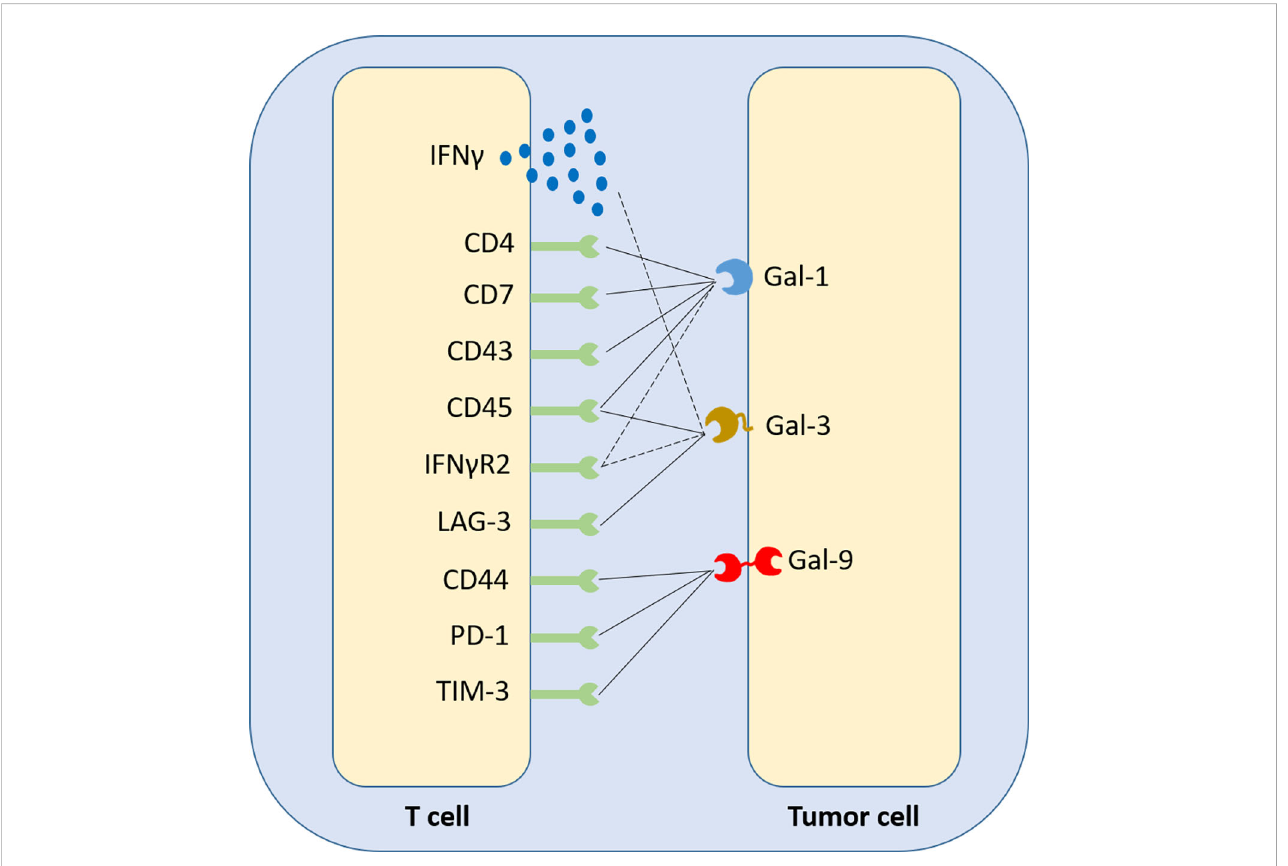
FIGURE 4 Synthetic representation of the crosstalk between galectins and T-cell surface receptors. Gal-1, Gal-3 and Gal-9 have been identi fi ed to be ligands of various membrane receptors, acting as checkpoint inhibitors. Depending on the member of the galectin family and the biology of the respective T-cell membrane receptor, or secreted cytokine, the immunosuppressive effect of galectins on T cells may have three distinct forms; two direct, causing T-cell apoptosis or a switch towards an exhausted phenotype (solid lines) and one indirect, suppressing T-cell-generated extracellular stimuli that could induce a greater immune response if they exited the tumour microenvironment and reached circulation (dashed